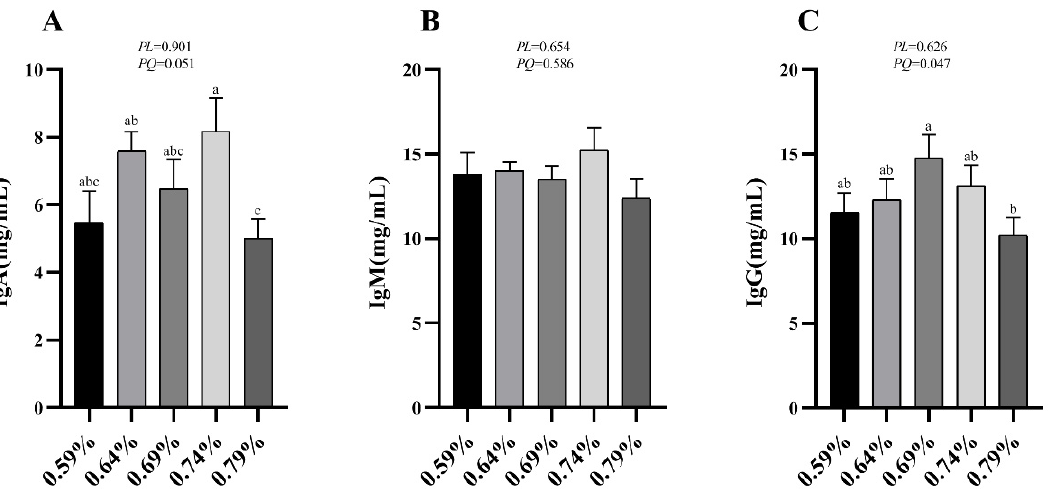
Figure 1. Effects of dietary valine levels on serum immune indices of laying hens. Values are represented as the mean and SEM (n = 8). Means with different superscript letters (a–c) within a column differ significantly ( p < 0.05). IgA, Immunoglobulin A; IgM, Immunoglobulin M; IgG, Immunoglobulin G.